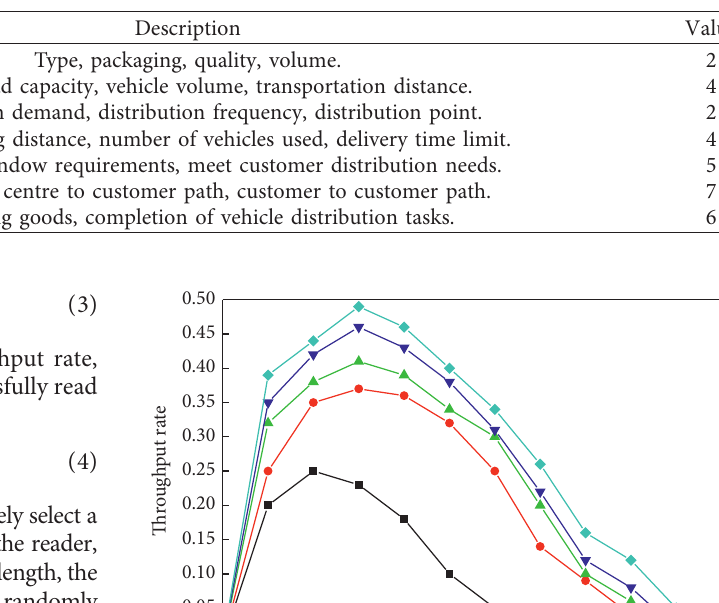
Table 1: Scaling